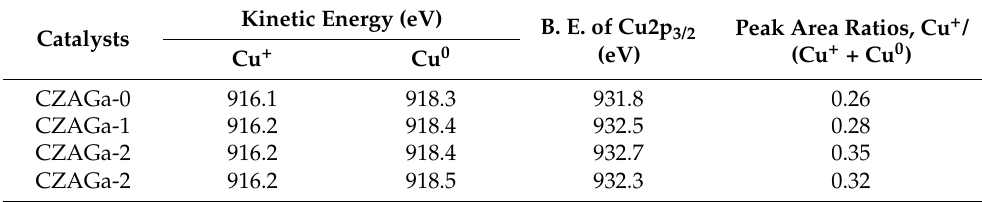
Figure 7. Cu LMM XAES spectra of the calcined catalysts. ( a ) CZA, ( b ) CZAGa-1, ( c ) CZAGa-2, ( d ) CZAGa-3. Table 2. Deconvolution of Cu LMM XAES of the reduced